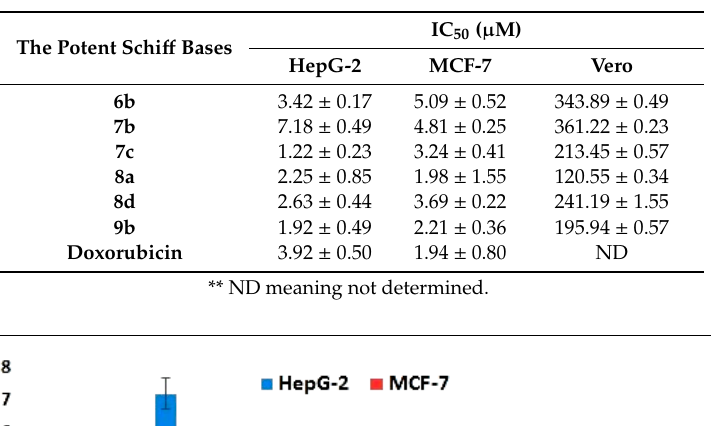
Table 4. The IC 50 ( µ M) of Schi ff bases ( 6b , 7b , 7c , 8a , 8d , and 9b ) against the two cancer cell lines